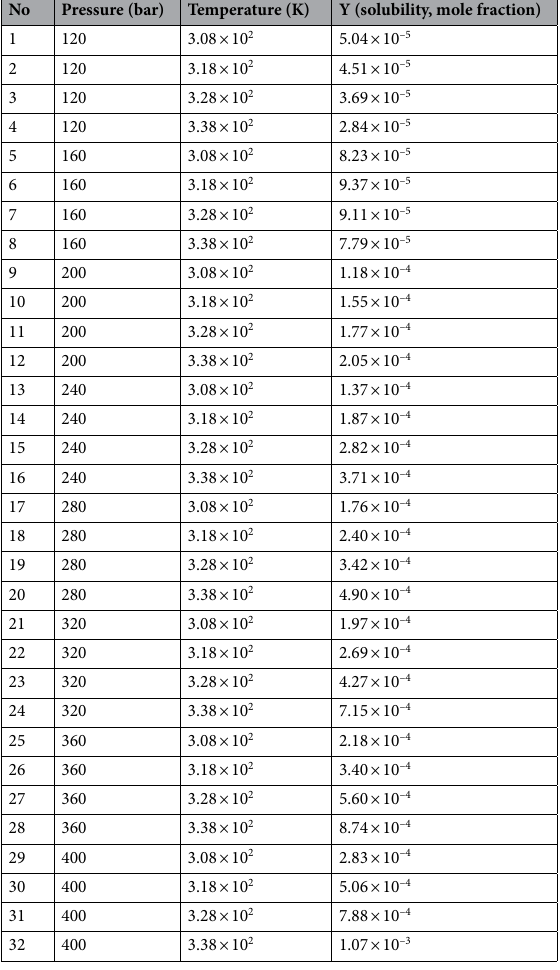
Table 1. The whole dataset 46,47